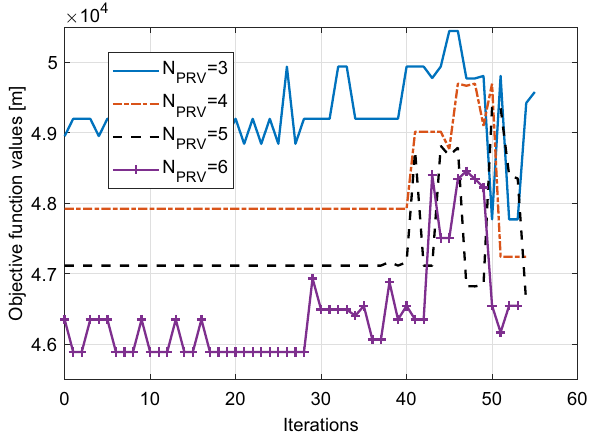
Fig. 9 Objective function values for the case N PRV =